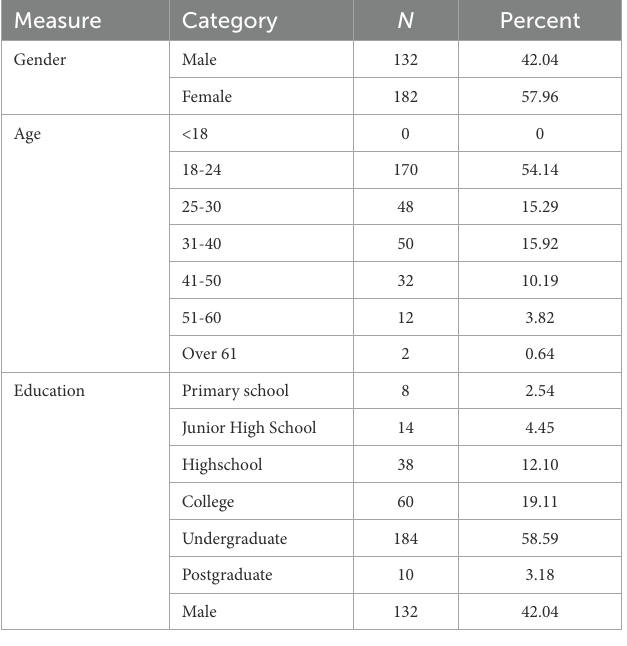
TABLE 1 Demographic profile of respondents ( N = 314).